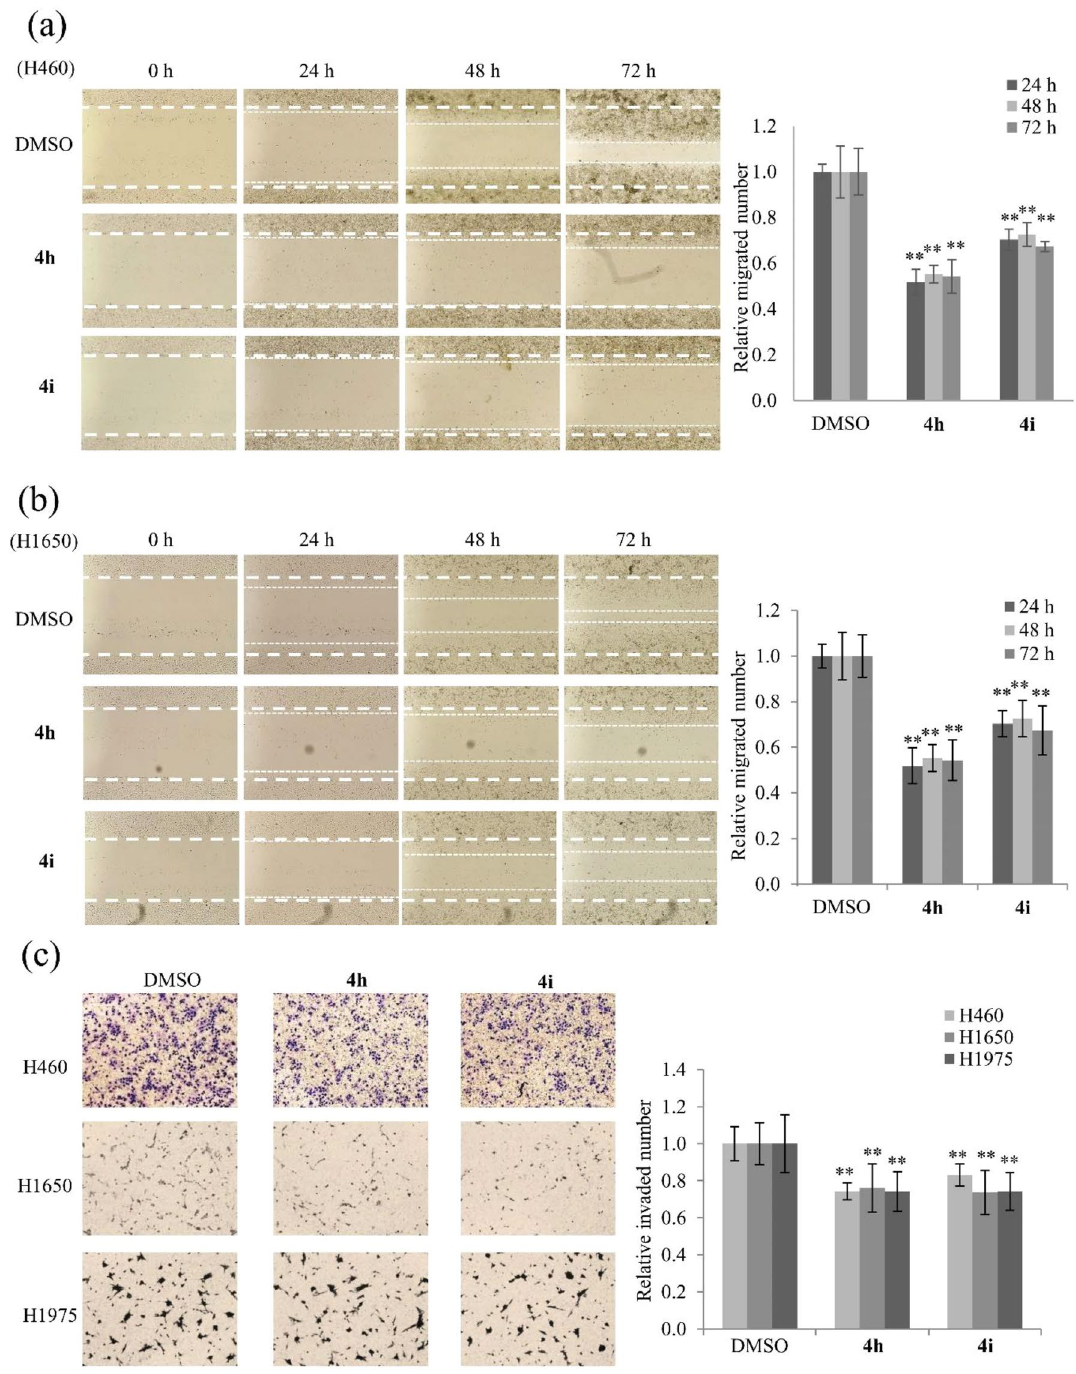
Figure 6. Inhibition of migration and invasion migration of different lung cancer cell lines by compounds 4h and 4i . ( a , b ) Representative images and quantitative analysis of migration assays of H460, and H1650 cells treated with 15 μM of compounds 4h and 4i for 24, 48, and 72 h. ( c ) Representative images and quantitative analysis of invasion assays of H460, H1650, and H1975 cells treated with 15 μM of compounds 4h and 4i for each cell line. Representative images from three independent experiments are shown (n = 3). Data represent the mean ± SD. * p < 0.05, ** p < 0.01 compared with DMSO-treated